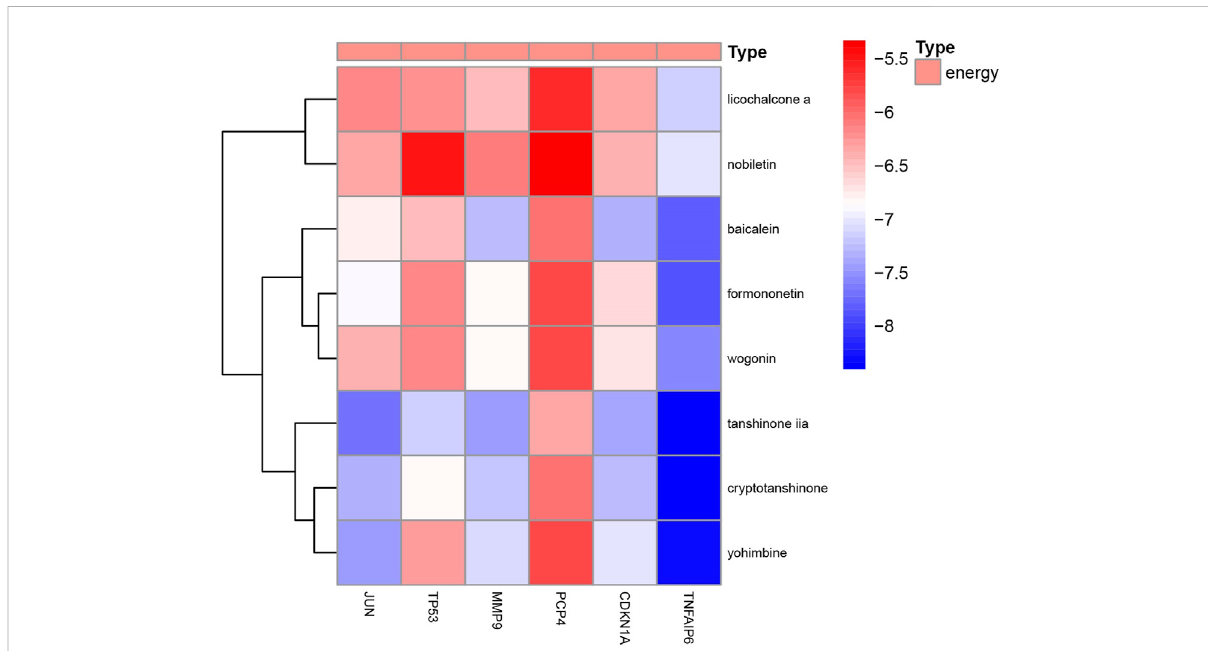
FIGURE 8 Molecular docking energy heat map. Molecular docking of JUN,TP53,MMP9,PCP4, CDKN1A AND TNFAIP6 proteins in Figure 4 was performed with the corresponding small molecule drugs in the network, and the docking energy was drawn into a heat map. Red represents high docking energy required, and blue represents low docking energy